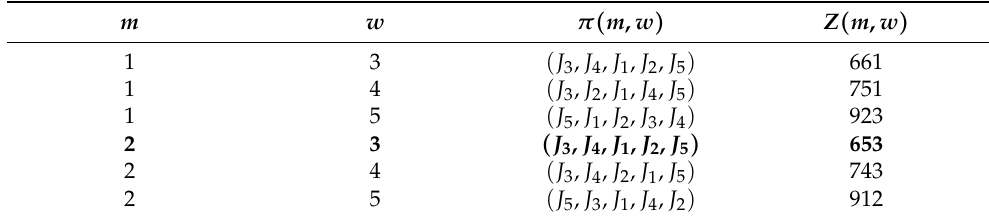
Table 3. Results of problem P 1 (bold numbers are the optimal solution).